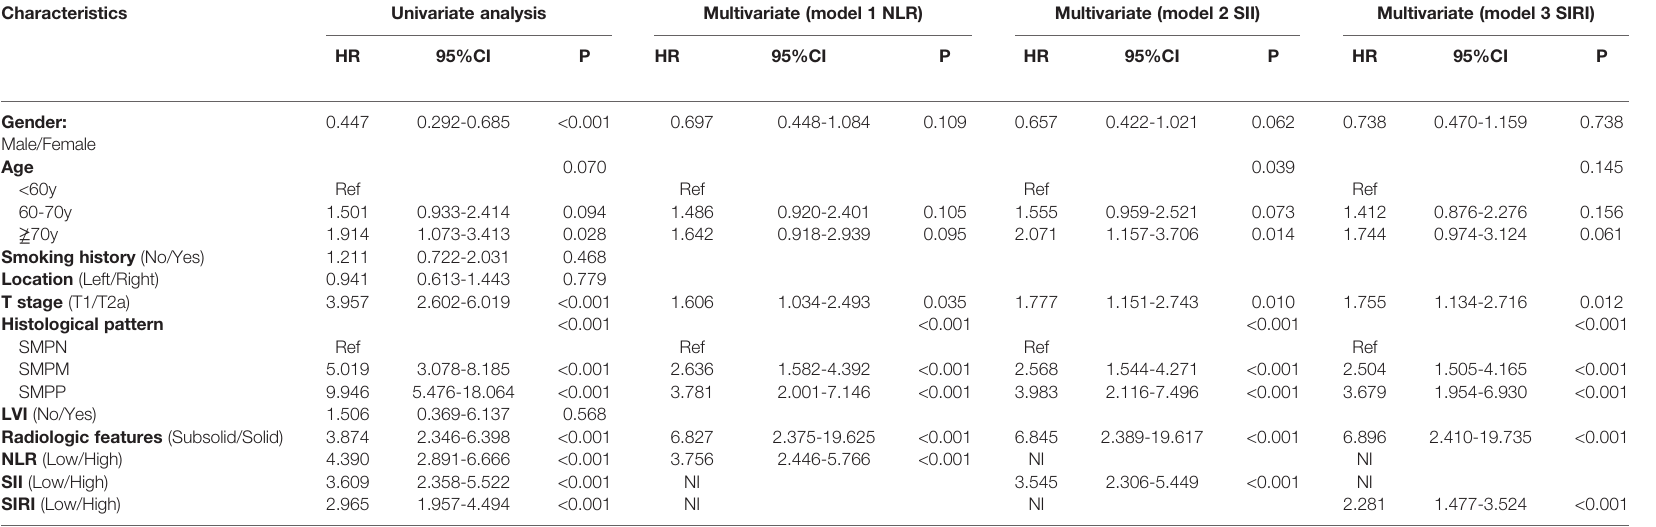
TABLE 3 | Univariate and multivariate cox regression analysis of factors associated with cancer-speci fi c